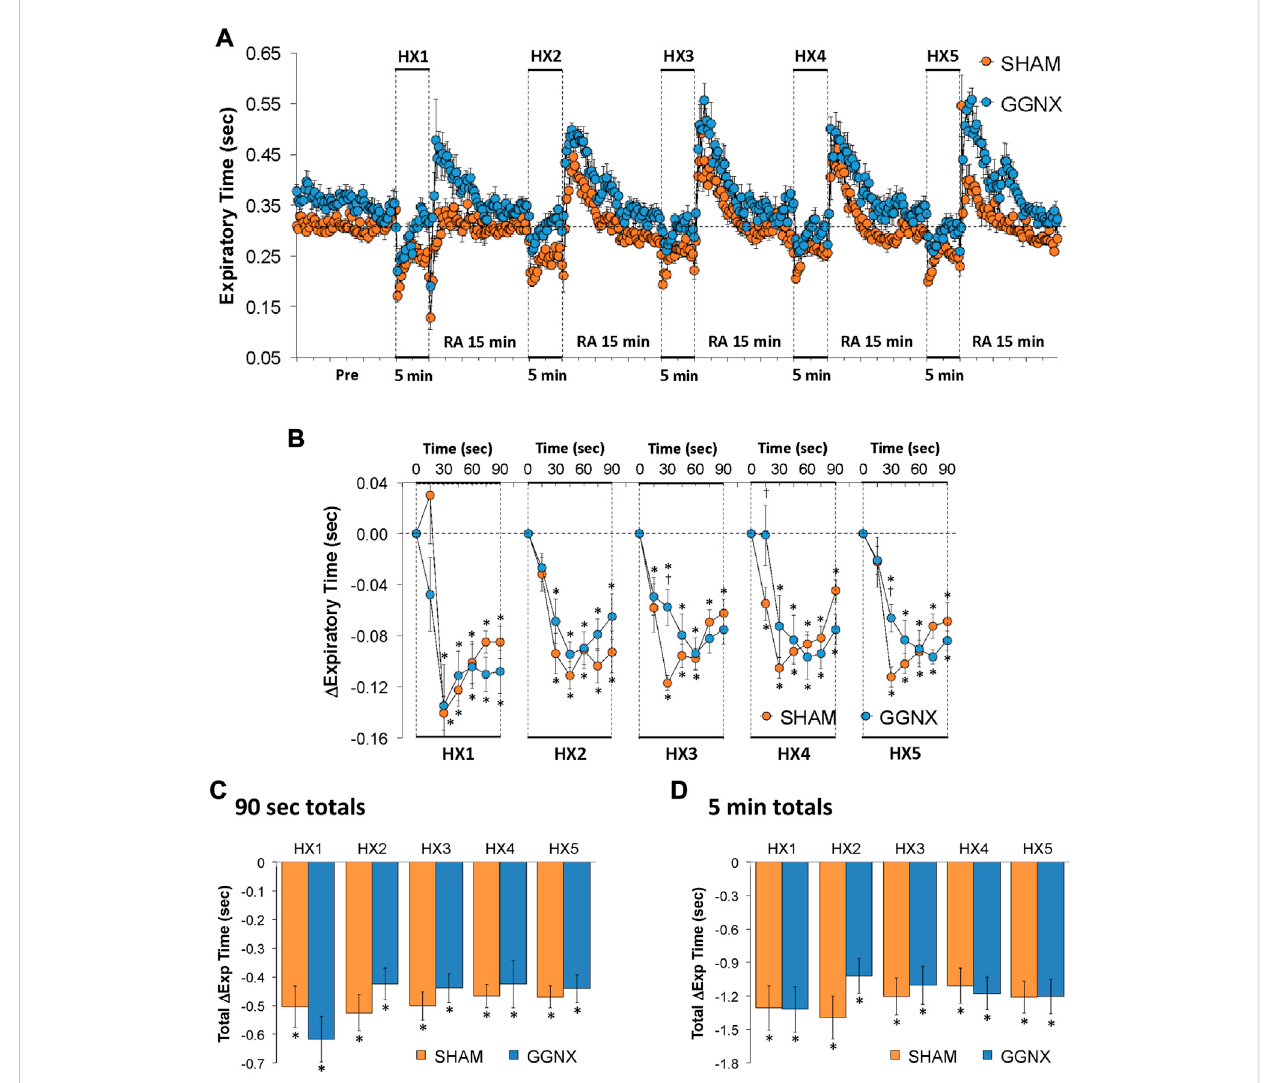
FIGURE 7 (A) Expiratory time in sham-operated (SHAM) rats and in rats with bilateral ganglioglomerular nerve transection (GGNX) before (Pre) and during fi ve hypoxic (HX,10%O of HX gas challenge. The SHAM group had 10 rats. The GGNX group had 12 rats. The data are presented as mean ± SEM. * p < 0.05, signi fi cant response. † p < 0.05, GGNX rats versus SHAM